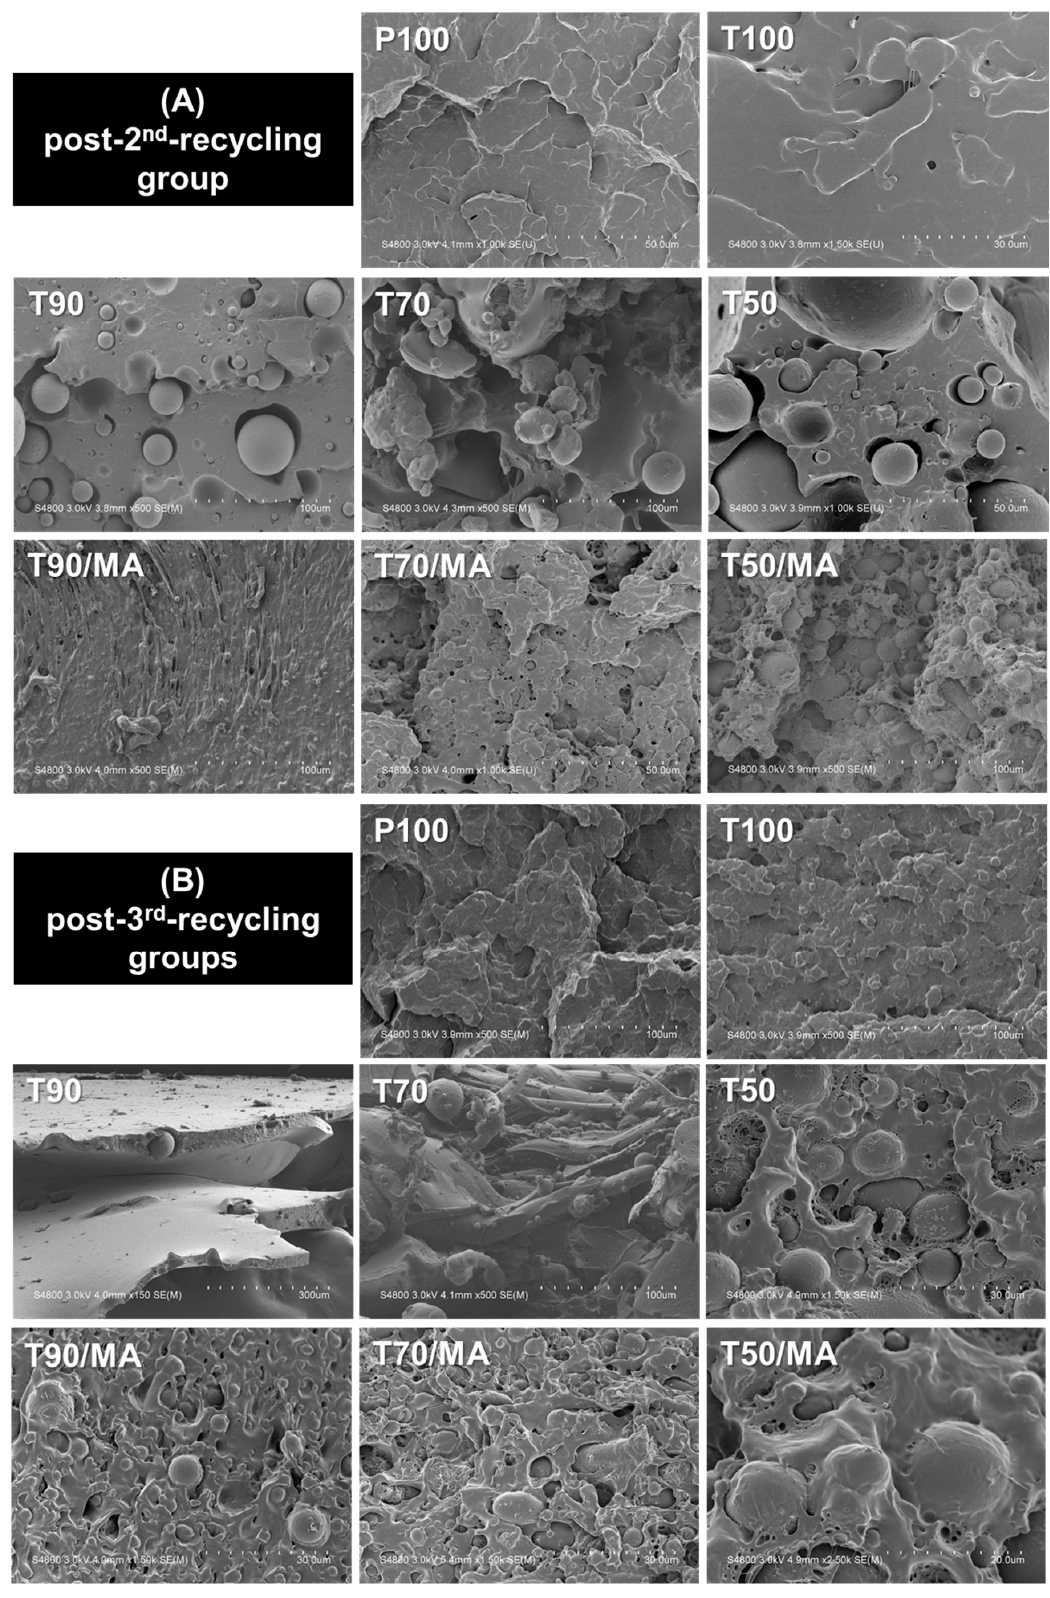
Figure 3. SEM images of post-2nd-recycling and post-3rd-recycling T/P and T/P/MA blends. ( A ) Post-2nd-recycling group; ( B ) post-3rd-recycling group.